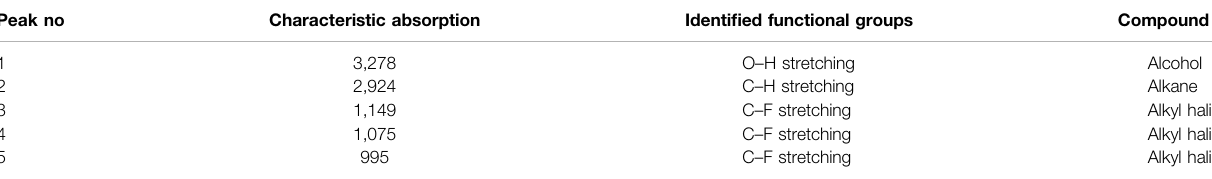
TABLE 6 | FTIR spectrum chart indicating the identi fi ed functional groups in N. sativa seed powder. Peak no